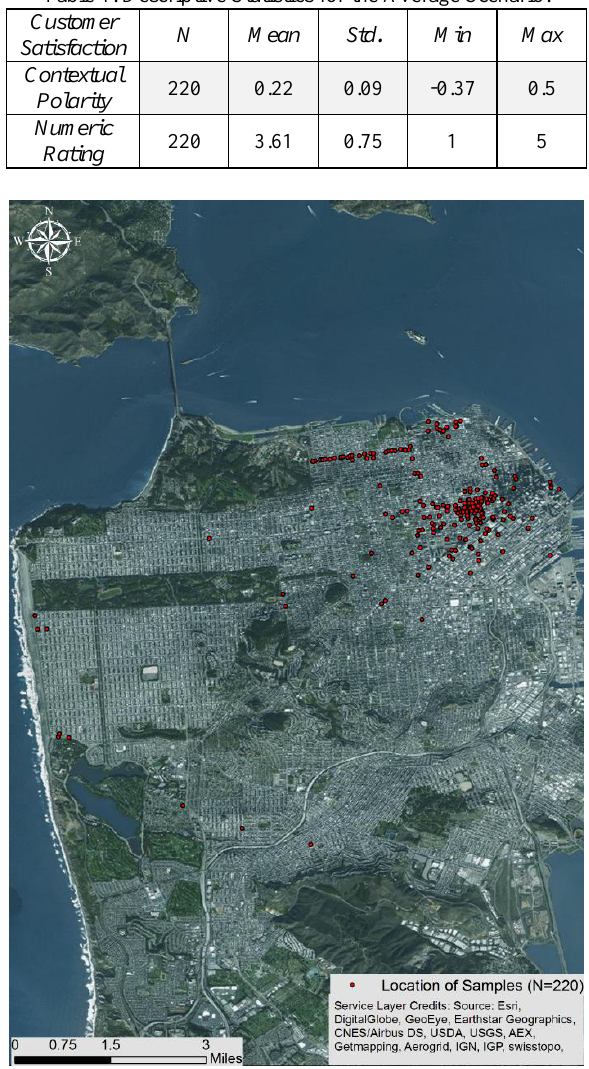
Table 1. Descriptive Statistics for the Average Scenario.